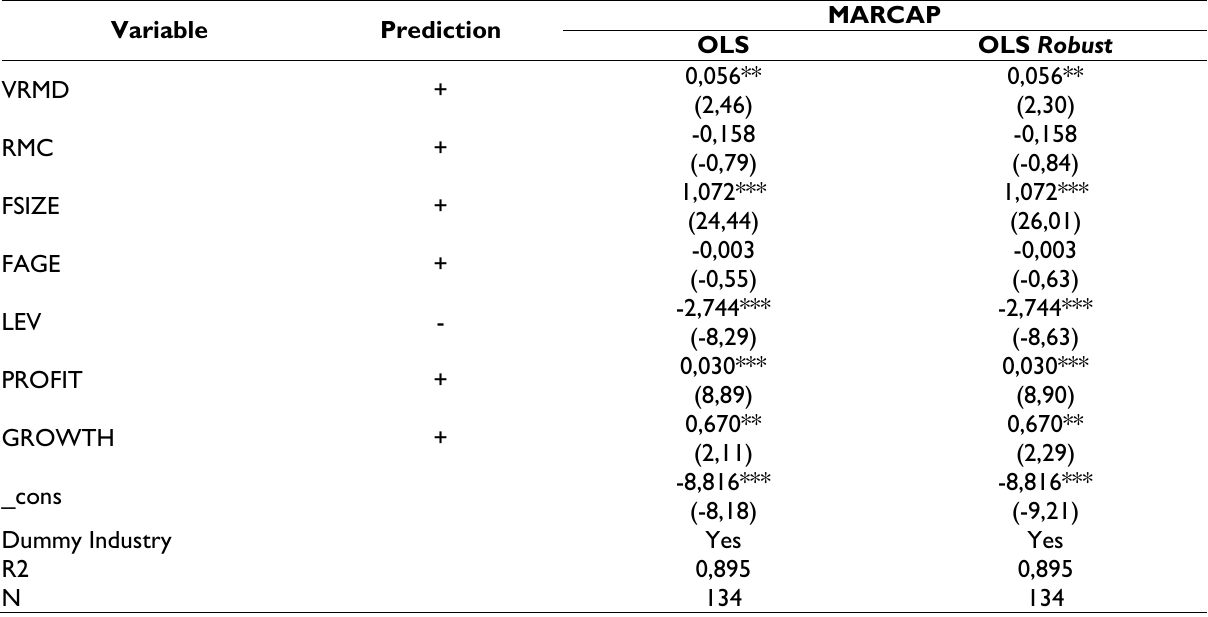
Table 5. OLS Results: Disclosure of Voluntary Risk Management (VRMD) and Risk Management Committee (RMC)